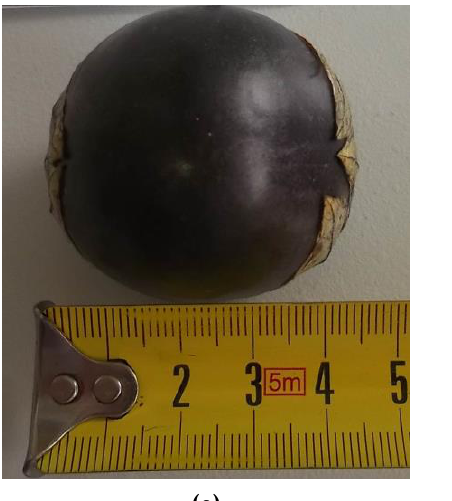
Table 3. Some characteristics of husk tomato production averaged over five experimental sites (mean ± standard deviation). Parameter